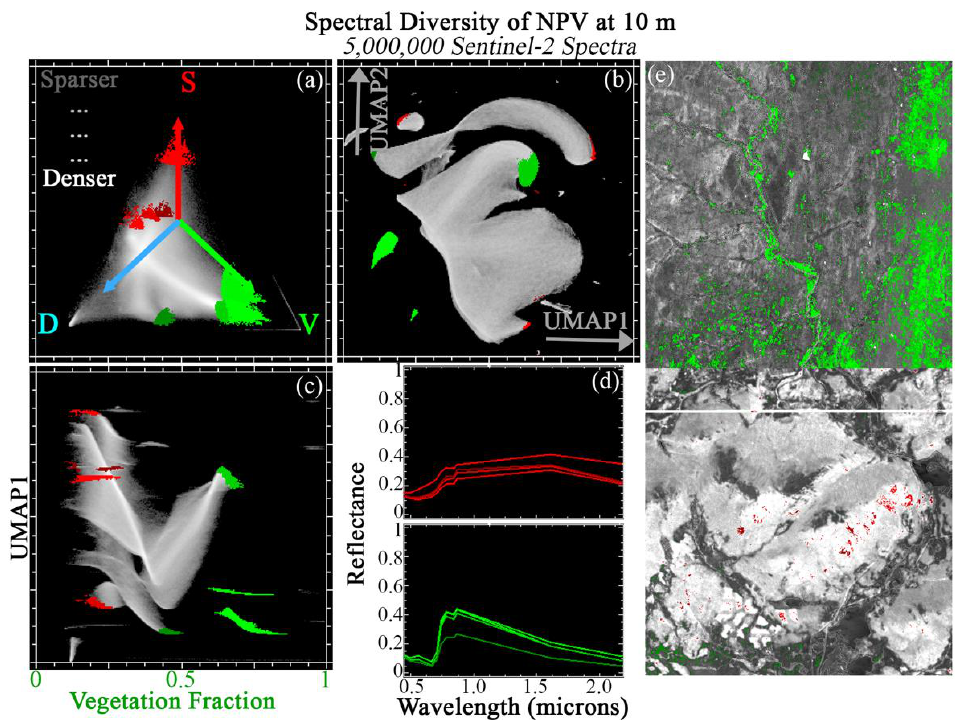
Figure 10. Joint characterization of senescent vegetation. 5 × 1 megapixel Sentinel-2 tile subsets are selected from global forest diversity hotpots and analyzed at full 10 m pixel resolution. These spectra preferentially occupy the V to D apexes of the SVD mixing space ( a ), leaving the S portion of the space relatively sparse. The global 3-endmember linear mixture model fits these spectra better than the agricultural spectra (here, 99.9% of spectra with <5% RMSE). UMAP ( b ) captures both subtle mixing continua and discrete clusters, but does not offer physical interpretability. Joint characterization ( c ) uses the physical meaning of the Vegetation mixture fraction to contextualize the subtle statistical relationships captured by UMAP. Example regions of interest are identified from the joint space and projected onto the ternary mixing and UMAP spaces. Mean spectra for each region ( d ) illustrate similarities and differences among statistically distinct clusters. Clusters identified by joint characterization also frequently show geographic coherence ( e ).